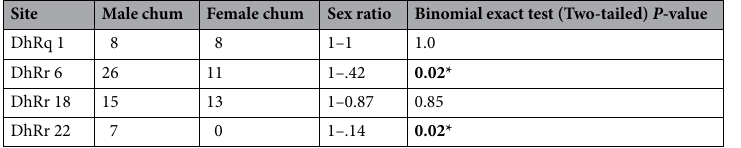
Table 3. Summary of sexed chum salmon by archaeological site. Statistically significant results at a α = 0.05 level of significance are in bold font and marked with an asterisk.